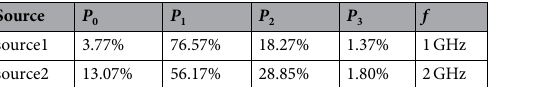
Table 1. Optimized one-cavity photon-blockade sources (PBS) when f = 1 GHz, κ = 5 GHz and f = 2 GHz, κ = 10